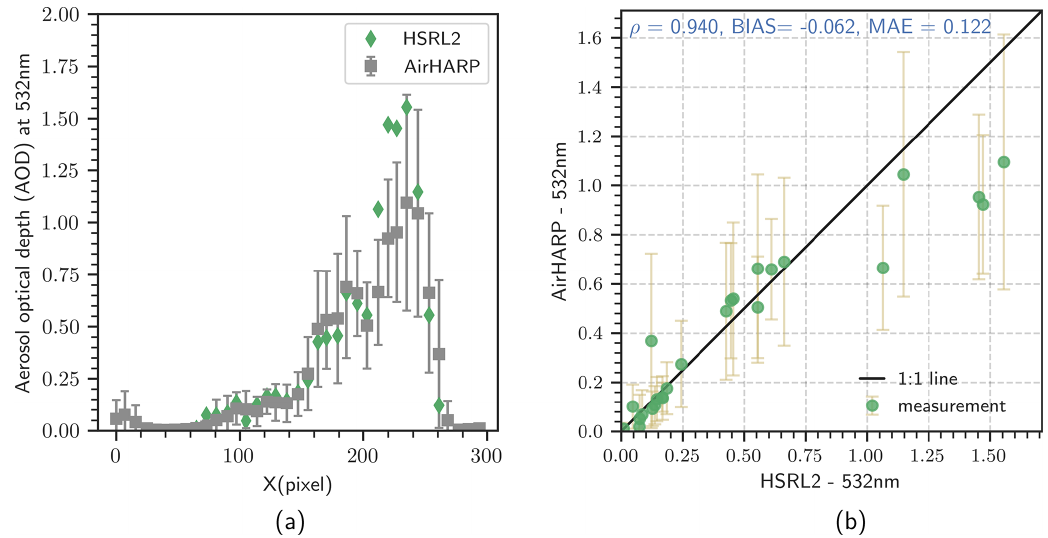
Figure 13. (a) AOD at 532nm from AirHARP vs. HSRL2 AOD at 532nm along the flight track for the forest fire scene on 9 November 2017, T19:30UTC; (b) correlation plot for the HSRL2 AOD at 532nm vs. AirHARP AOD at 532nm for the same flight.